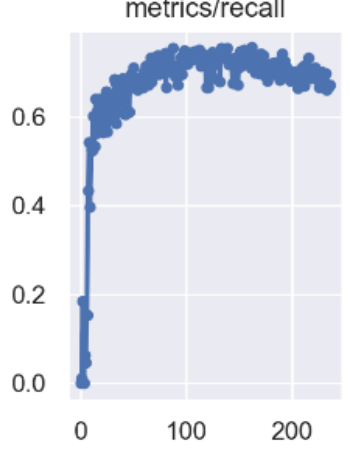
Figure A12. The change of mean average precision (mAP) of YOLOV5l: ( a ) mAP_0.5; ( b ) mAP_0.5:0.95.